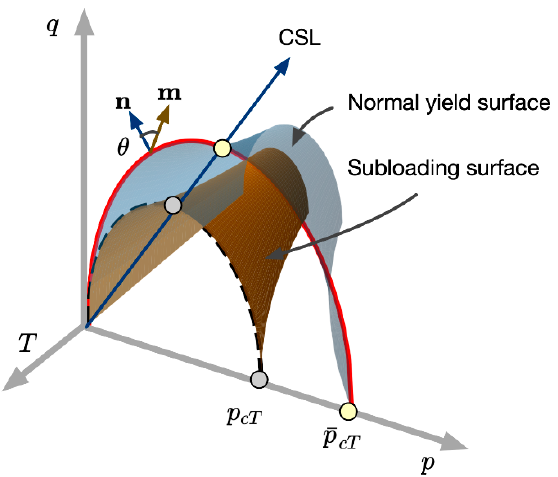
Figure 3. The schematic of the temperature-dependent subloading surface concept.